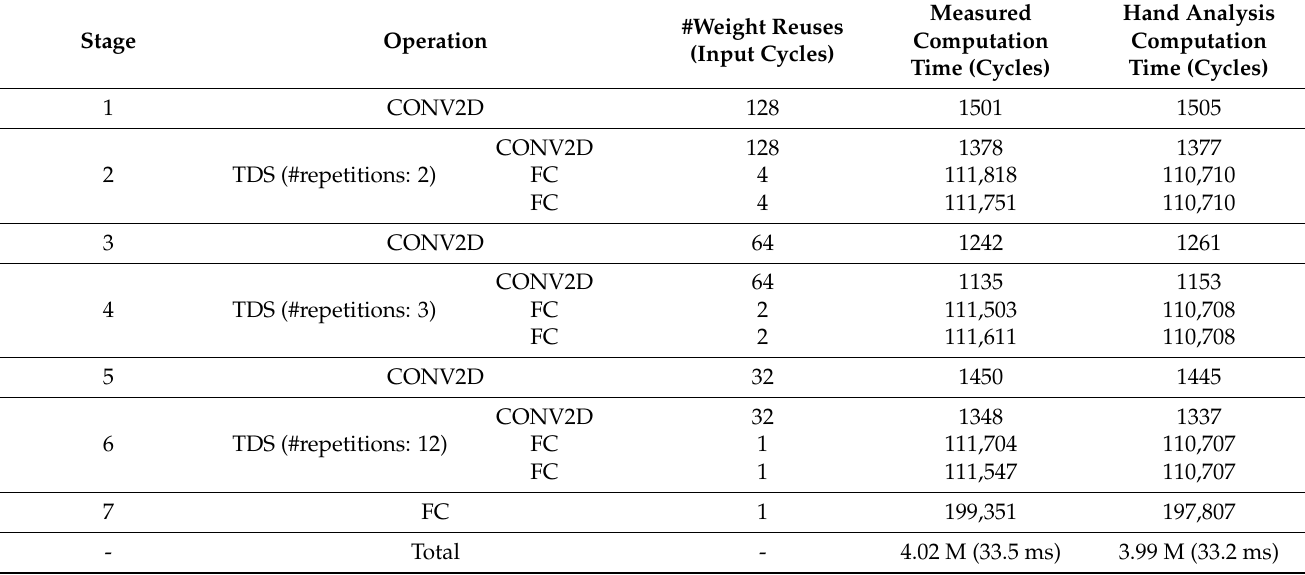
Table 13. Computation time of proposed AM at 80 ms unit input.